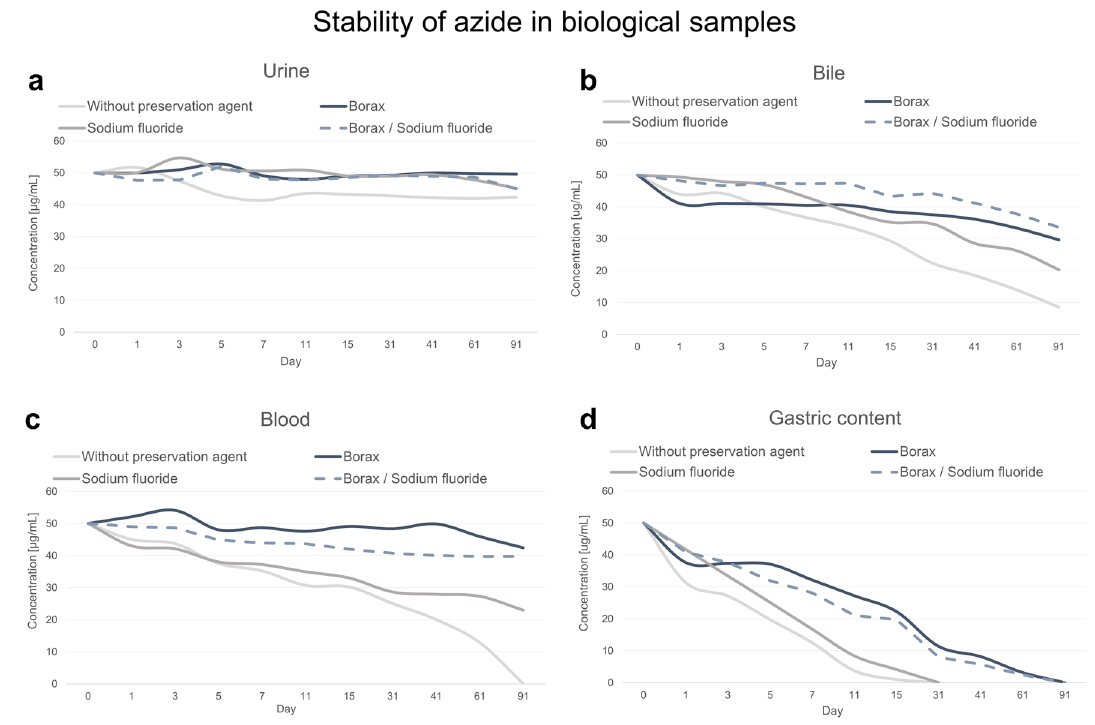
Figure 5. Stability of azide in biological samples—( a ) urine; ( b ) bile; ( c ) blood; ( d ) gastric content—collected in four types of tubes: without any preservation agent, with borax, with sodium fluoride, and with mix of borax and sodium fluoride ( w/w